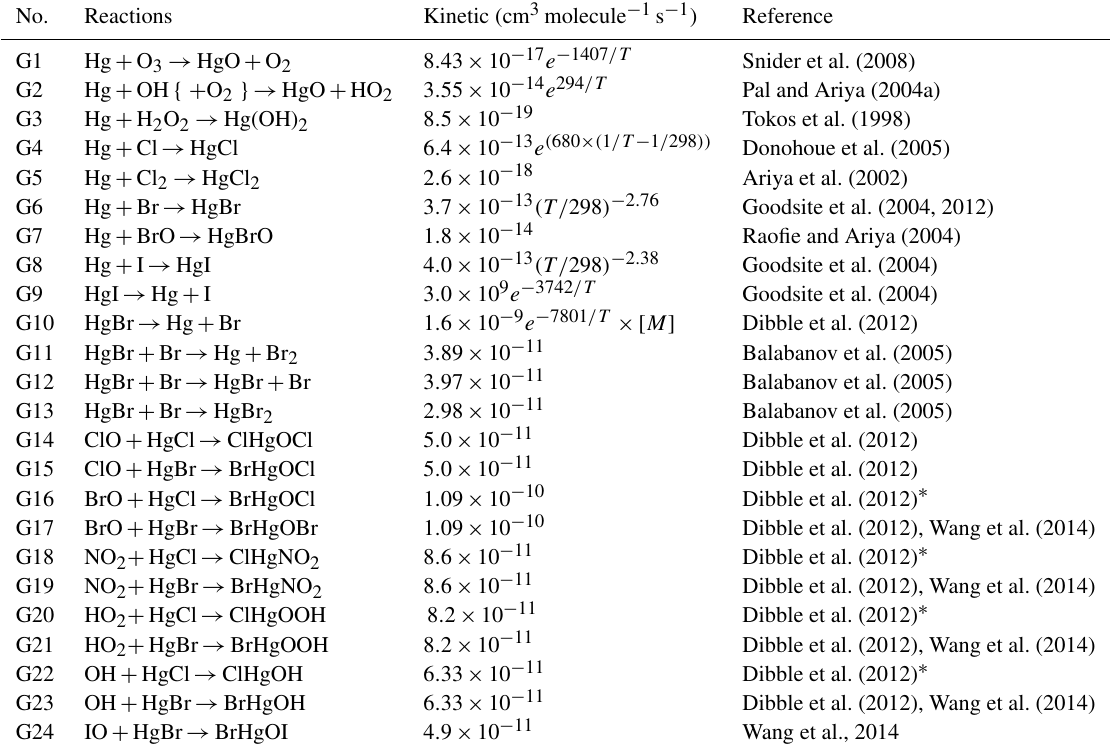
Table 1. Gas-phase Hg reactions in the box model.